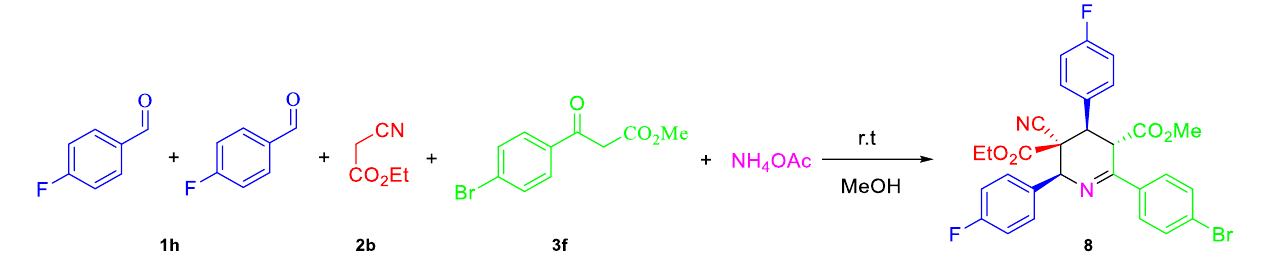
Table 4. Crystal data and structure refinement.